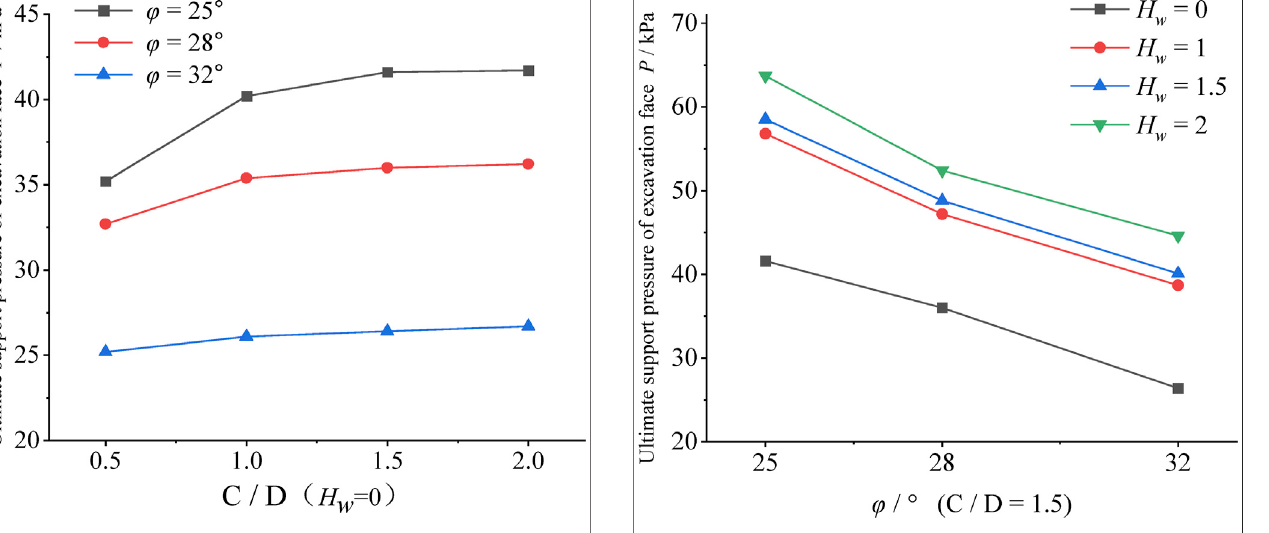
FIGURE 7 | Relationship between limit support pressure and internal friction angle of